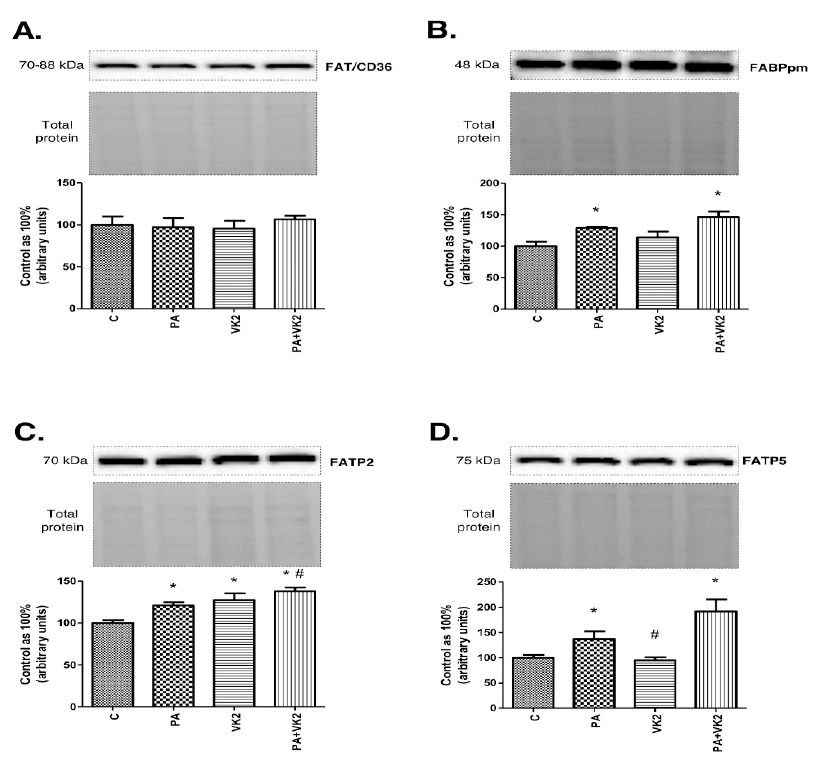
Figure 5. The expression of fatty acid translocase (FAT/CD36) ( A ), fatty acid-binding proteins (FABPpm) ( B ), fatty acid transport proteins 2 (FATP2) ( C ) and fatty acid transport proteins 5 (FATP5) ( D ) in HepG2 cells. The cells were incubated for 16 h with palmitic acid and/or vitamin K2. The expression of proteins involved in plasmalemmal transport of fatty acids were assessed by Western blotting as described in the Materials and Methods section. The results are presented as mean ± SD and are based on six independent determinations. *– P < 0.05 significant difference vs control group, #- P < 0.05 significant difference vs palmitate group; C–control, PA–palmitate, VK2– vitamin K2, PA + VK2–palmitate and vitamin K2.